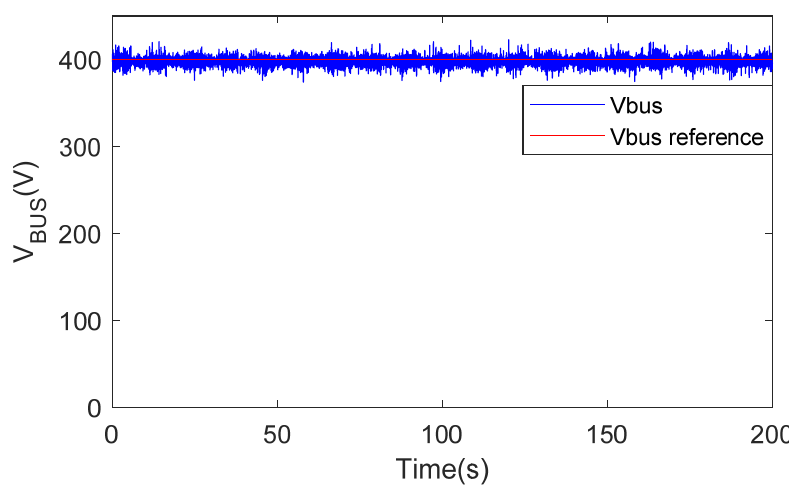
Figure 19. DC-bus voltage control result with the reference of 400V.